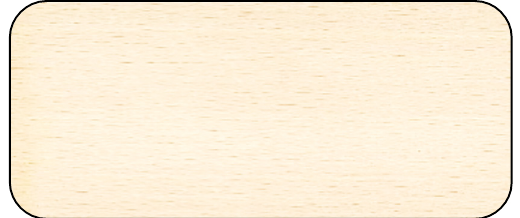
Figure 1. Native color of beech wood. Note: Reproduces from Dzurenda, L. Colouring of beech wood during thermal treatment using saturated water steams; published by Acta Fac. Xylologiae Zvolen, 2014, with permission from Acta Fac. Xylologiae Zvolen, 2022.